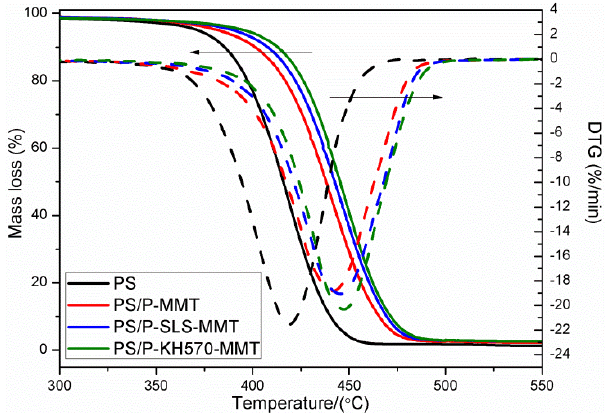
Figure 10. TGA and DTG curves of PS, PS/P-MMT, PS/P-SLS-MMT, and PS/P-KH570-MMT.